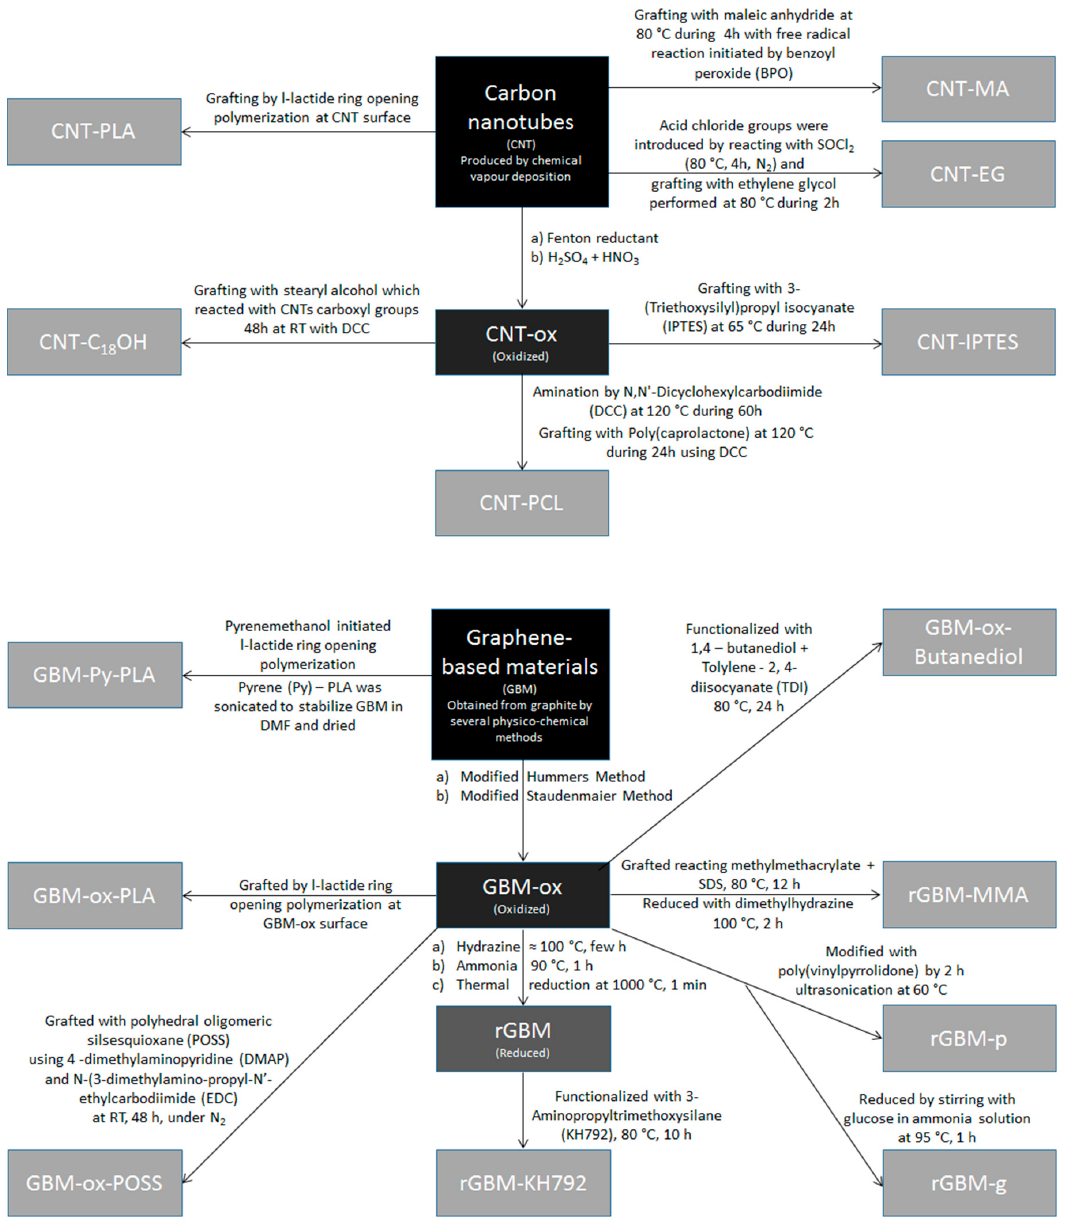
Figure 1. Scheme showing the different types of modifications performed on carbon-based nanomaterials (CBN) prior to incorporation in poly(lactic acid) (PLA).